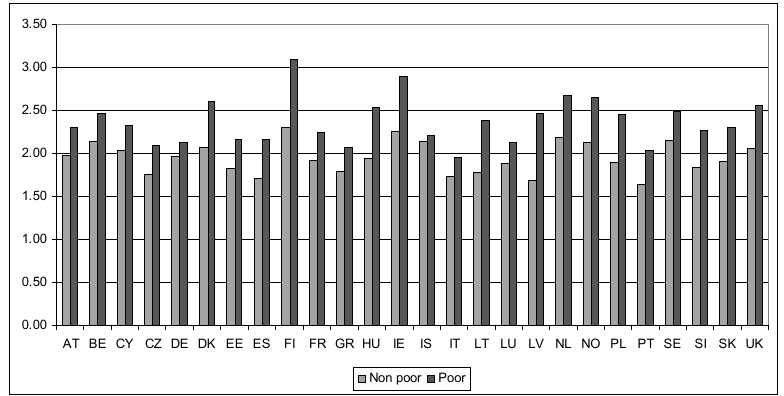
Figure 6 : Child poverty rate by educational level of the mother